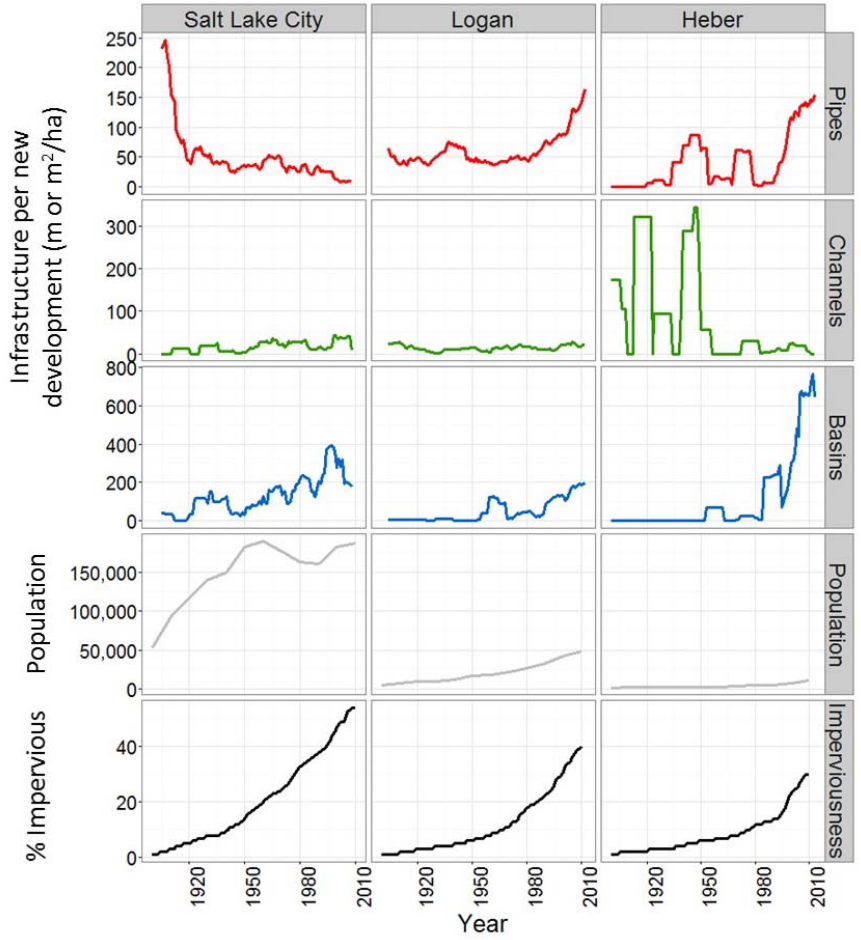
Figure 2. Annual infrastructure use (new infrastructure normalized by new development), population, and imperviousness (%) for Salt Lake City, Logan, and Heber City, UT from 1900 to 2010. Patterns of channel density over time were also highly variable across the three cities (Figure 3). Heber had by far the highest density of channels during early development, but that density has declined rapidly as new development occurs in areas with fewer legacy agricultural canals and no new canals are built. The density of canals in both Logan and Salt Lake City appear to be relatively stable over time, perhaps because there were no concentrated areas of canals or drainage ditches in these cities during early development. The use of retention and detention basins follows the most consistent pattern across the three cities (Figure 3). Basin density increased in all three cities at low levels of imperviousness and has increased steadily in all cities. The density of basins increased at similar rates in Logan and Salt Lake City but much more rapidly in Heber.